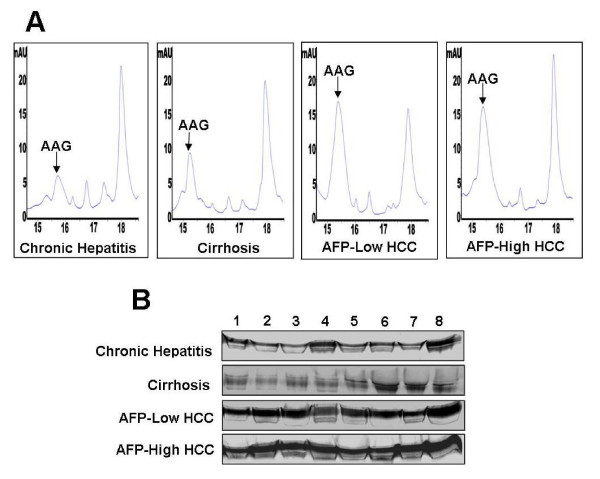
HPLC chromatogram profile and western blot analysis. (A) HPLC chromatogram profile of chronic hepatitis, cirrhosis, AFP-low HCC, and AFP-high HCC; (B) Western blot analysis of AAG in chronic hepatitis, cirrhosis, AFP-low HCC, and AFP- high HCC.